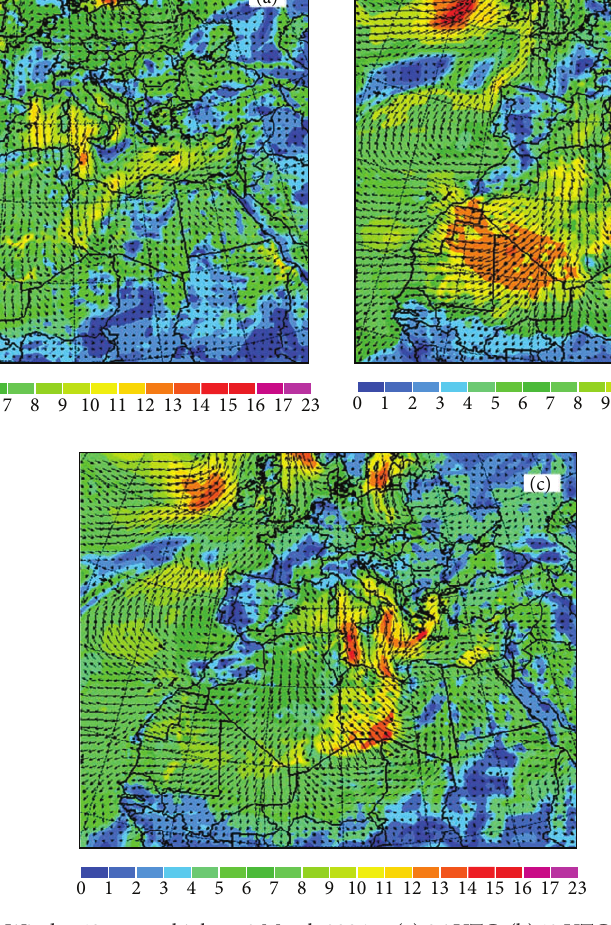
Figure 3: Wind at 10 meters high on 3 March 2004 at (a) 06 UTC, (b) 12 UTC, and (c) 18